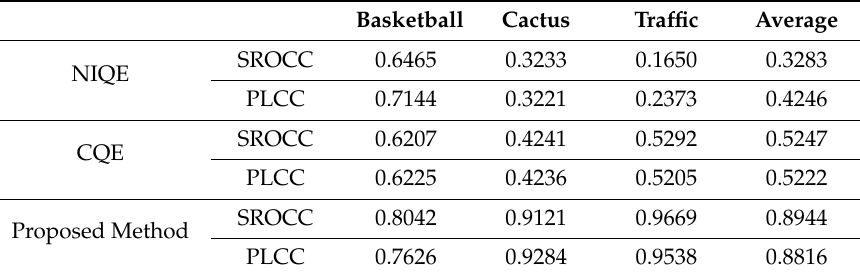
Table 1. Performance comparison between the conventional methods (NIQE, CQE) and the proposed method. Two difference correlation metrics called SROCC and PLCC were calculated between the scores measured by the automatic methods and by the subjective evaluation.